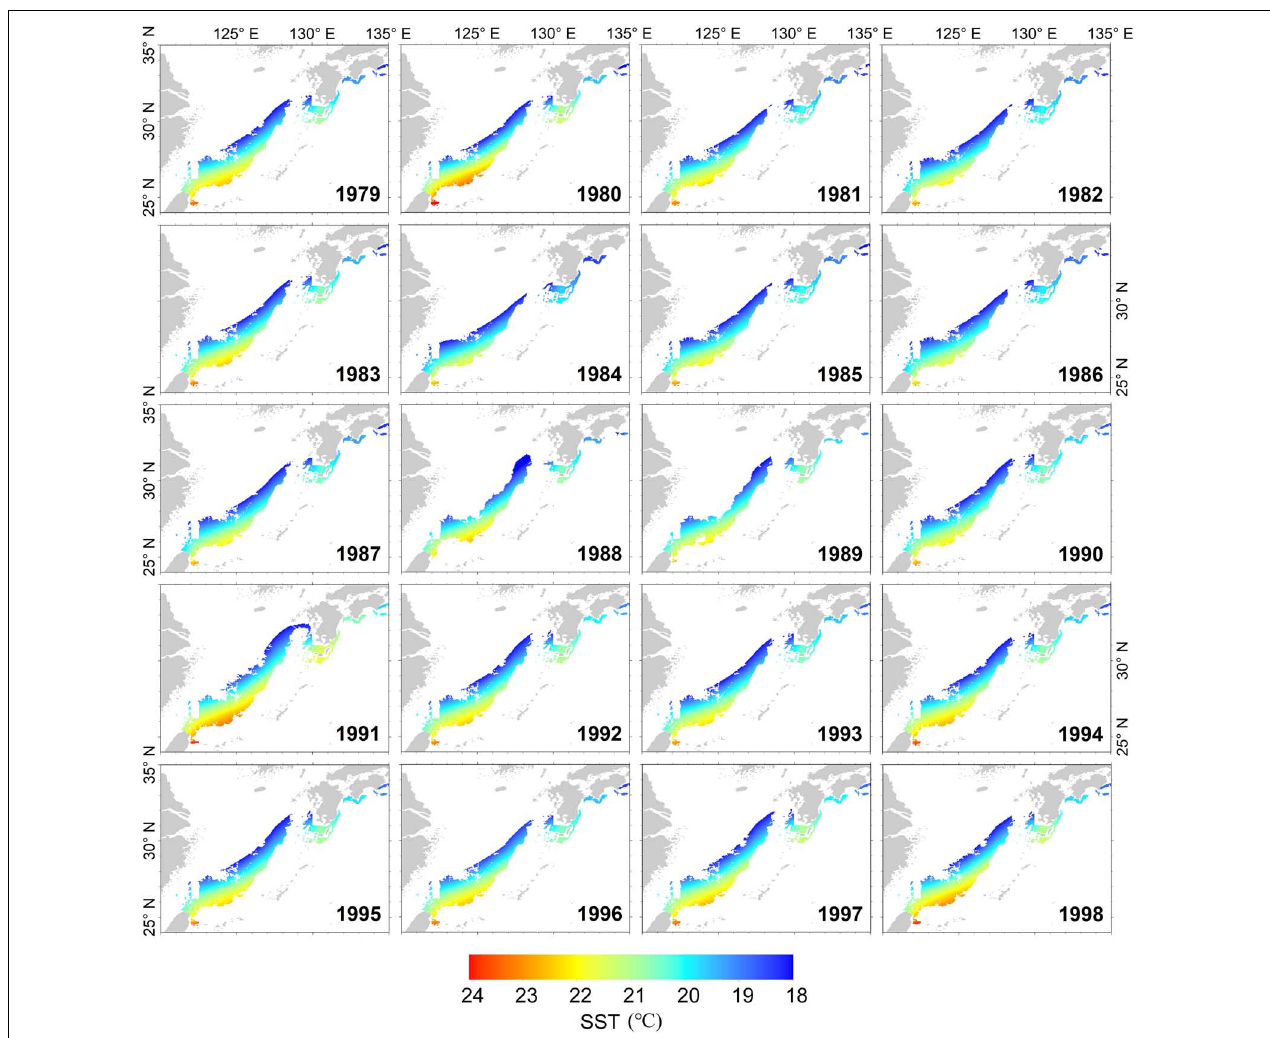
FIGURE 4 | The annual dynamic potential spawning ground of winter cohort of Japanese flying squid from 1979 to